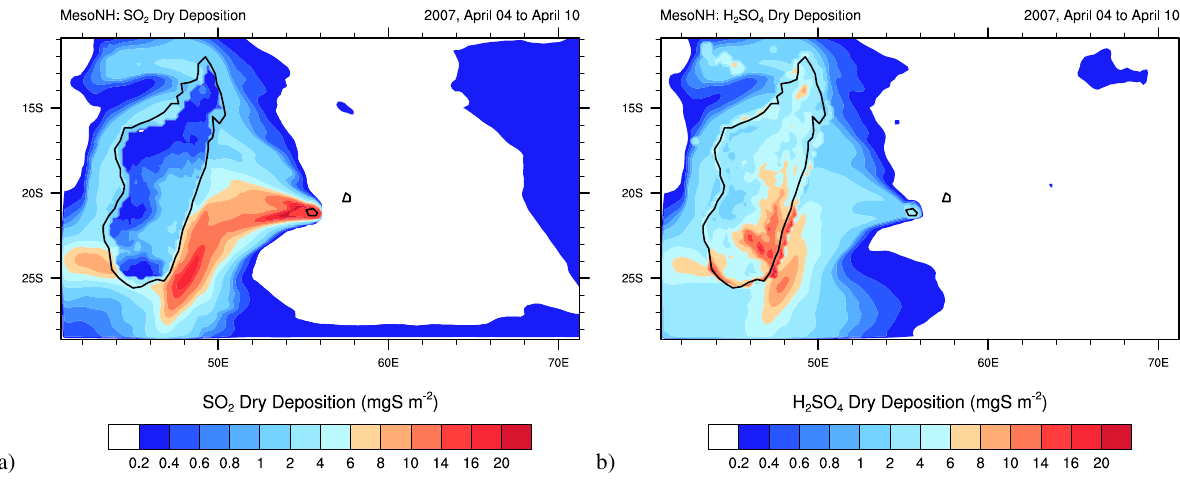
Fig. 7. Surface dry deposition of SO 2 (a) and H 2 SO 4 (b) (mgSm − 2 ), simulated by MesoNH between 4 April and 11 April 2007.